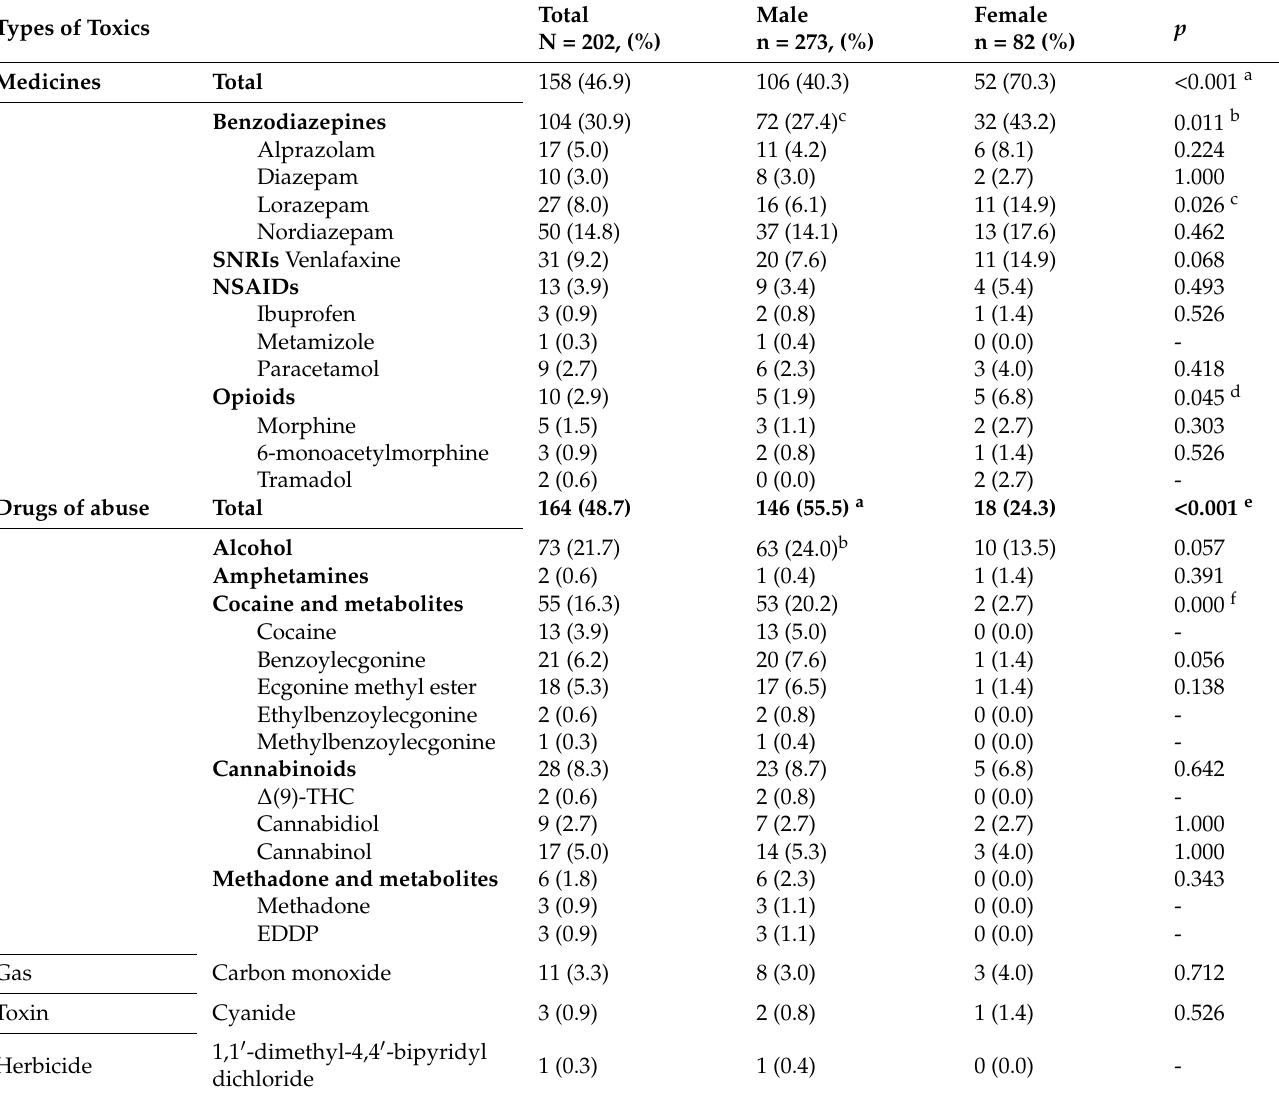
Table 3. Analysis of the types of toxics found according to the sex of the suicide